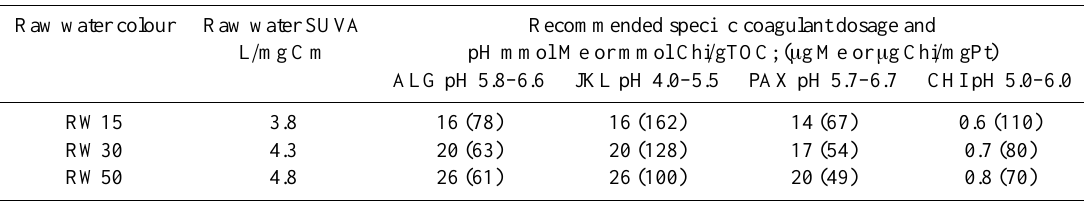
Table 1. Recommended pH and dose using alum (ALG), iron (JKL) or chitosan (Chi) in contact filtration of raw waters at color levels of 15, 30 and 50mgPt / L (Eikebrokk, 2001).